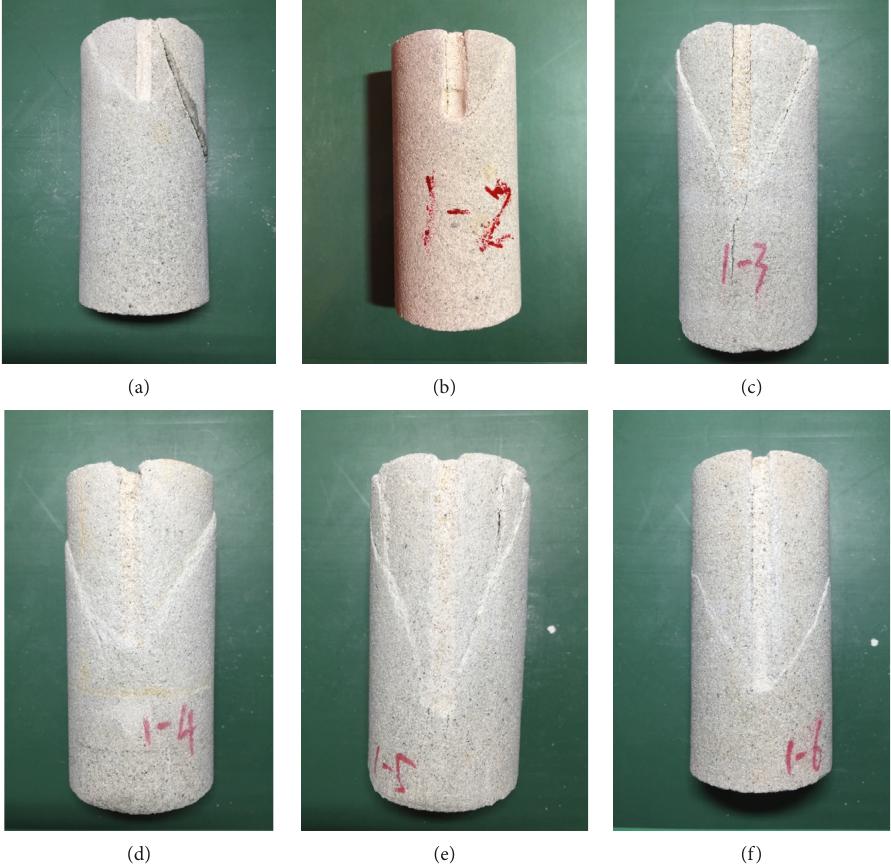
Figure 10: Destruction pictures of cracked sandstone filled with gypsum mortar. (a) 1-1. (b) 1-2. (c) 1-3. (d) 1-4. (e) 1-5. (f) 1-6.